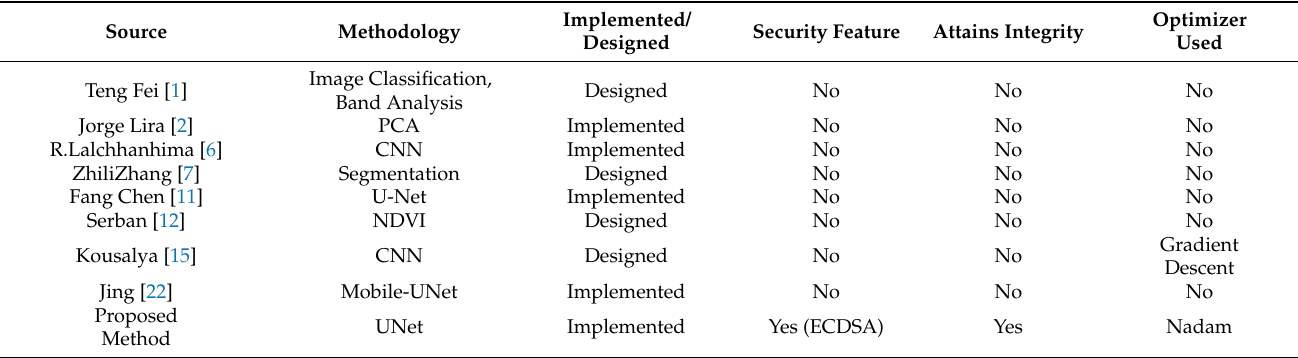
Table 1. Analysis of Literature